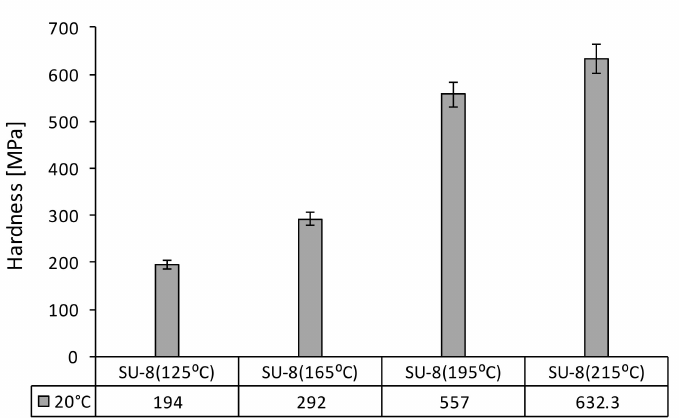
Figure 5. Hardness of SU-8 hard baked at 125 ◦ C, 165 ◦ C, 195 ◦ C, 215 ◦ C tested at 20 ◦ C.